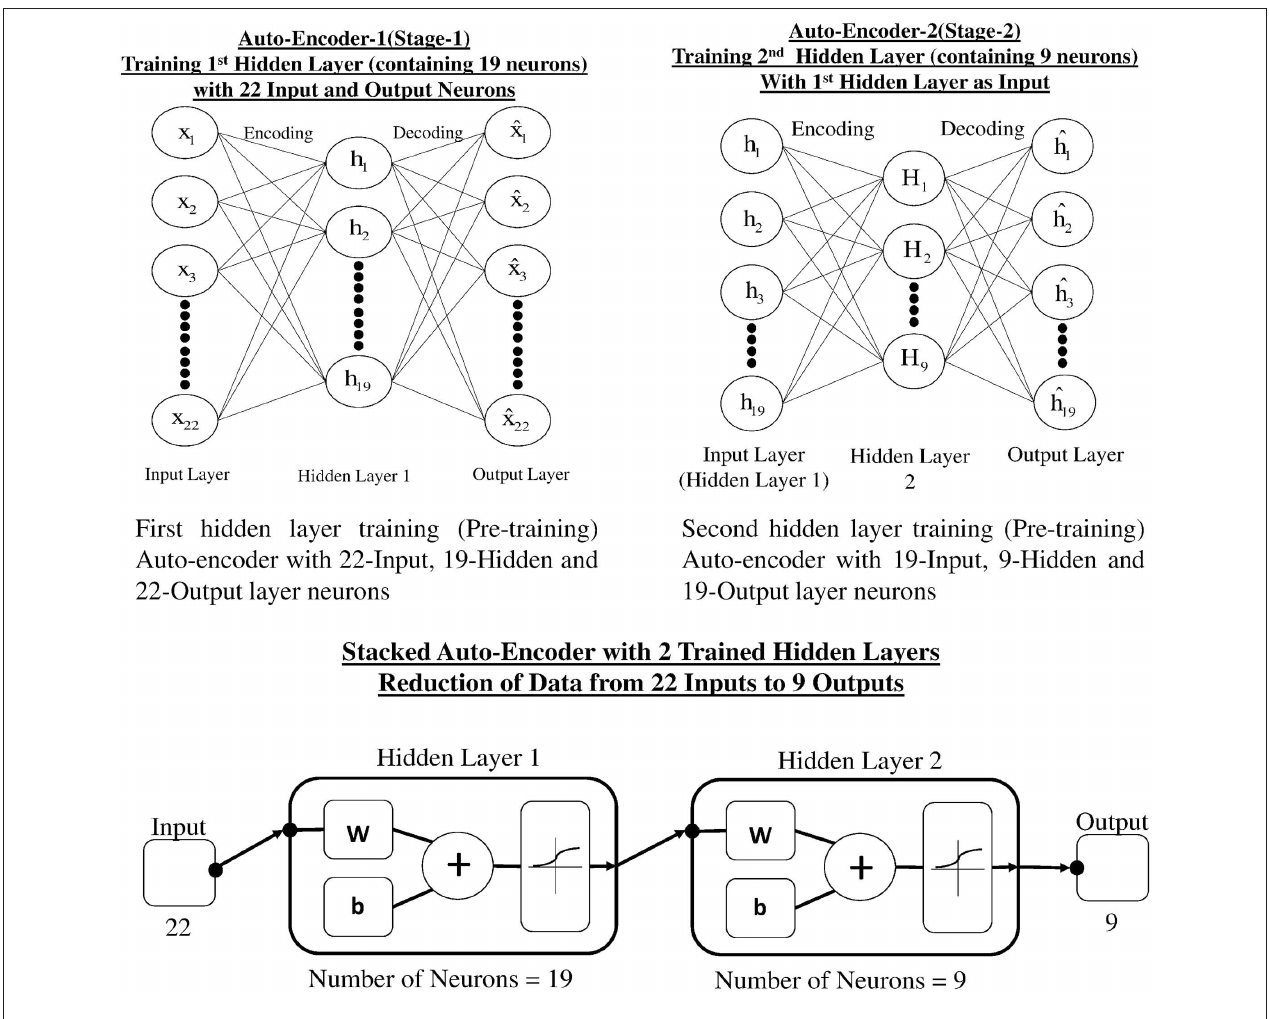
FIGURE 6 | Stacked auto-encoder with two pre-trained hidden layers and final reduction of data.